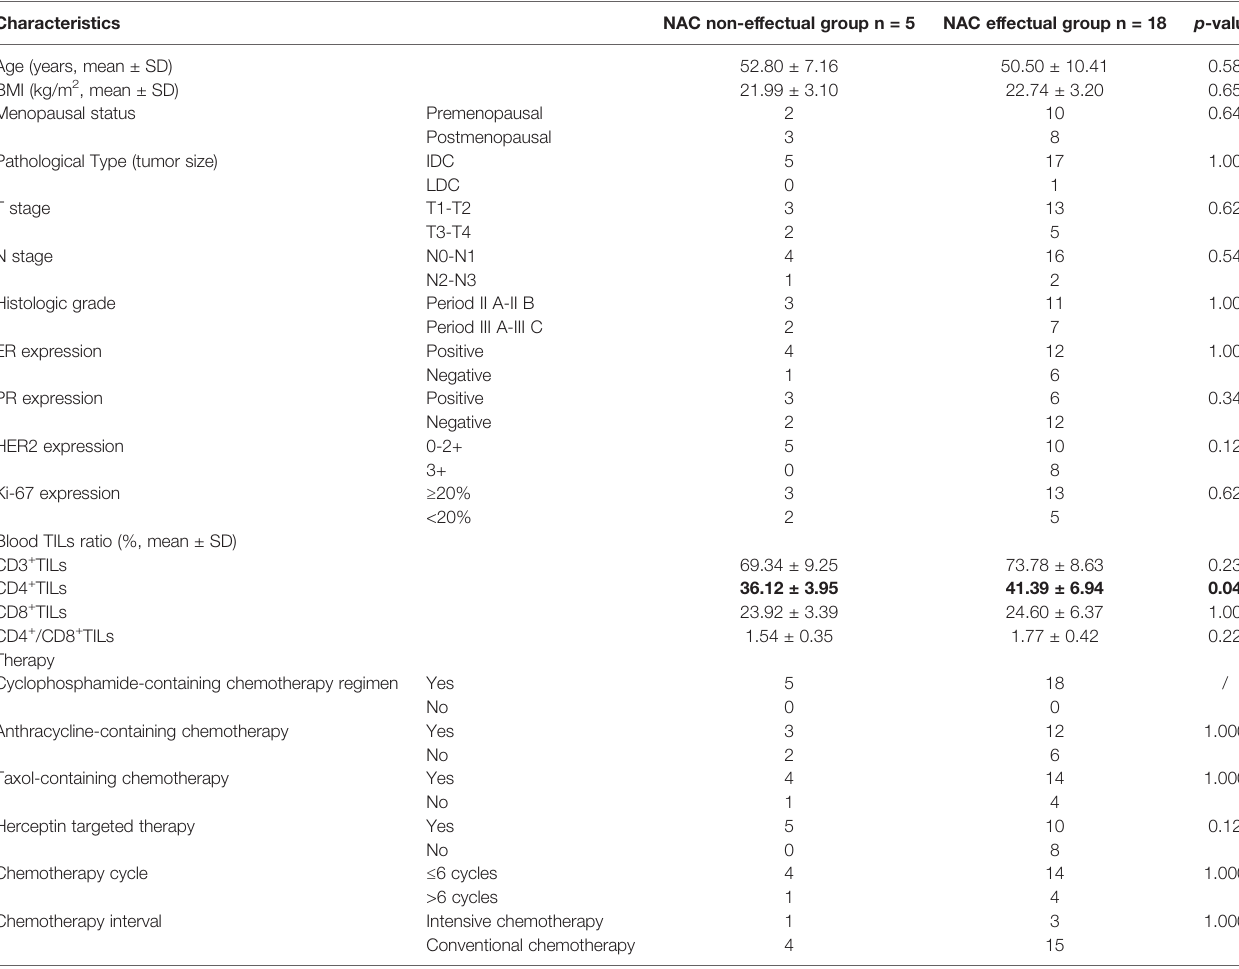
TABLE 1 | Comparison of clinical indices and pathological data between NAC non-effectual group and NAC effectual group.